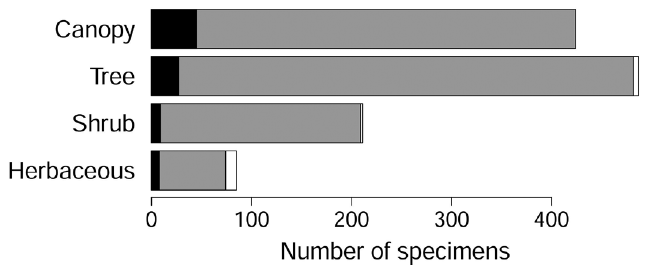
Fig. 11. Number of collected specimens in the different vegetation strata; black = females; grey = males; white = nymphs.